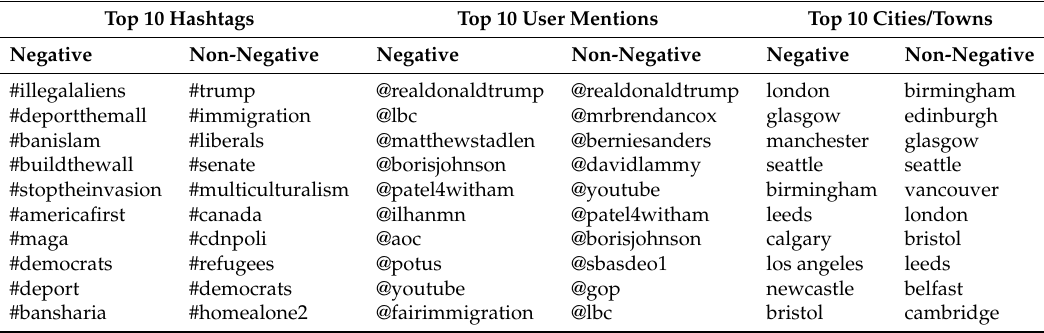
Table 2. Top 10 hashtags, user mentions and cities/towns for “Negative” and “Non-Negative“ classes. Top 10 Hashtags Top 10 User Mentions Top 10